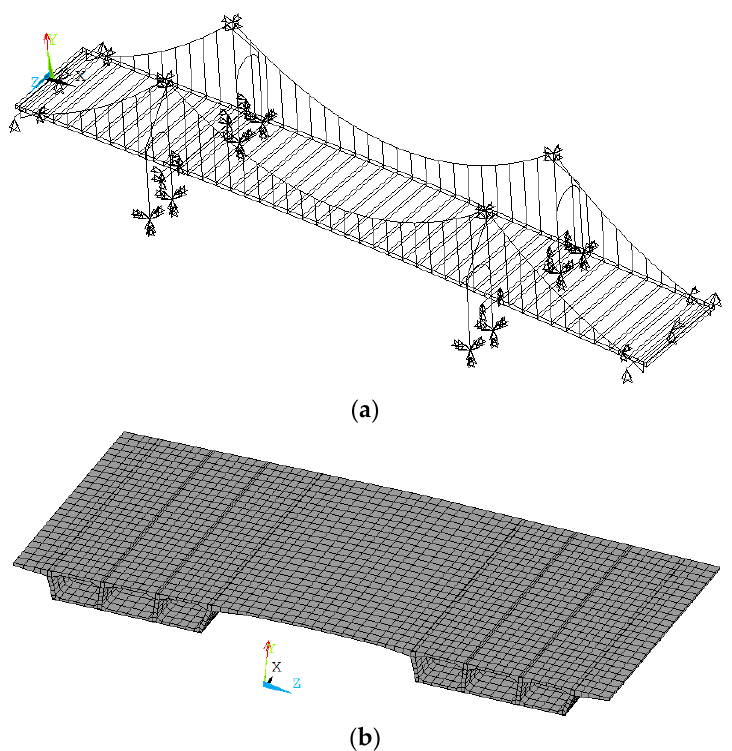
Figure 5. Finite element model: ( a ) Global model; and ( b ) Girder finite element of Beam 188.